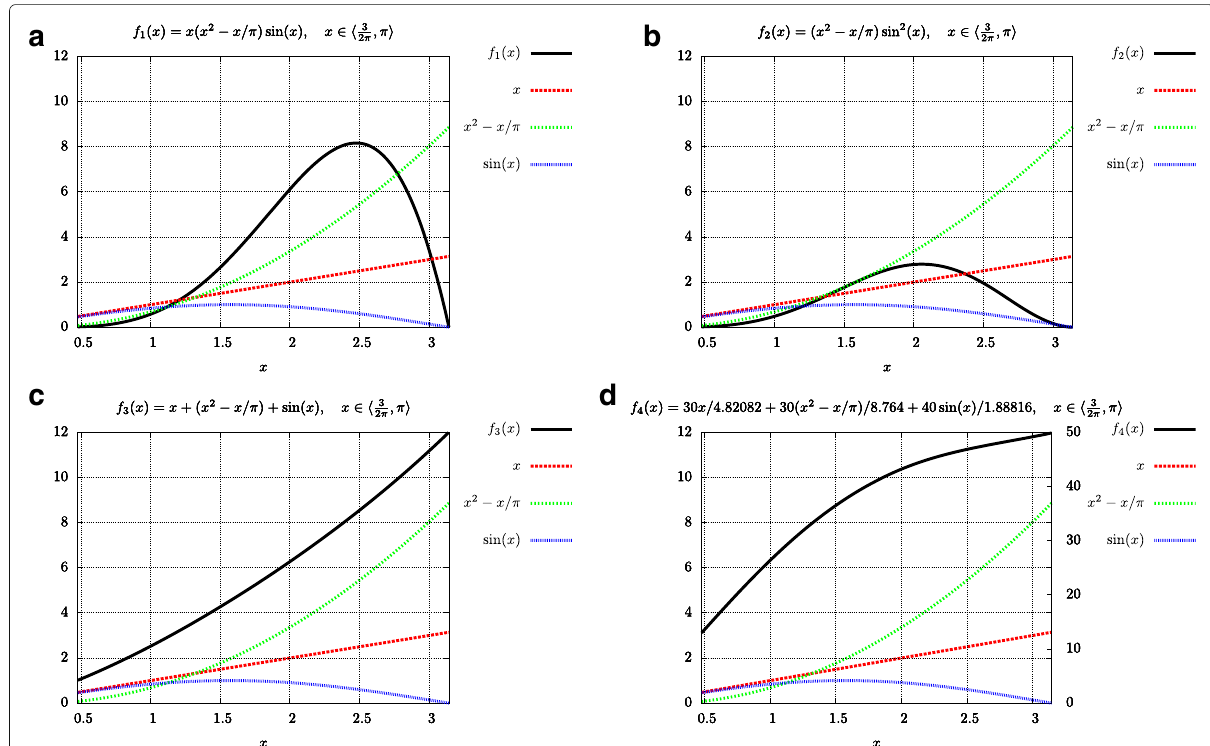
Fig. 1 From left to right and from top to bottom: The four functions (in black) used in the four examples, f 1 ( x ) (example 1), f 2 ( x ) (example 2), f 3 ( x ) (example 3), f 4 ( x ) (example 4), as combination of the three functions x (red), x 2 − x /π (green), and sin ( x ) (blue)